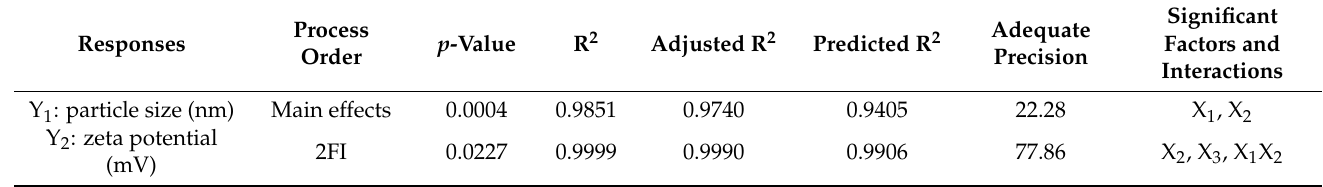
Abbreviations: SIT = sitagliptin; GA = glatiramer acetate; 2FI = two-factor